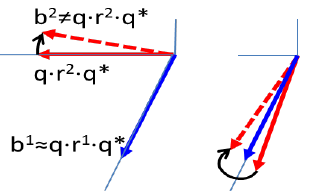
Figure 4. Good vector configuration ( Left ), and ill conditioned vector configuration ( Right ) for determining the attitude. The problem in the configuration on the right side is that a small error in a vector generates a considerable rotation error.